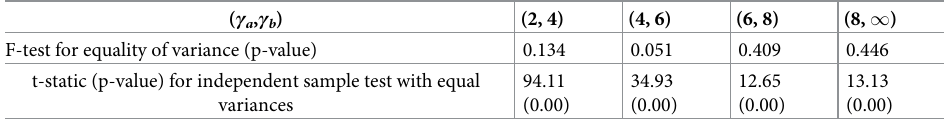
Table 3. Summary of hypotheses tests two-independent samples (sample size =